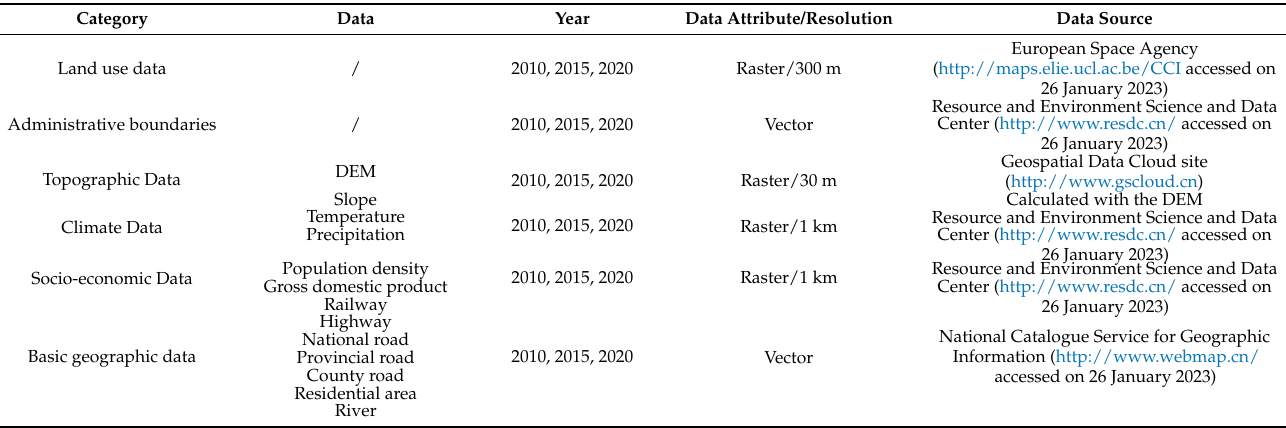
Table 1. Datasets used in the